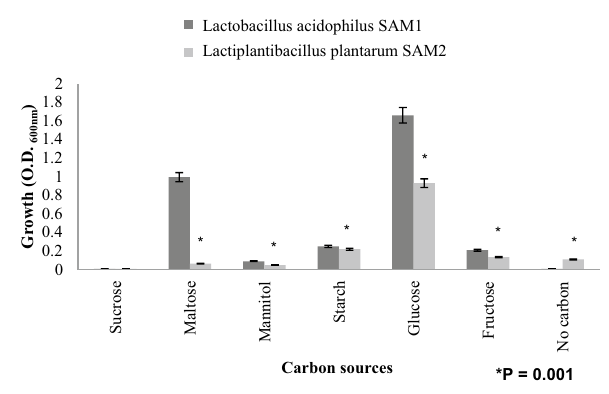
Figure 10. Influence of different carbon sources on growth of LAB strains.